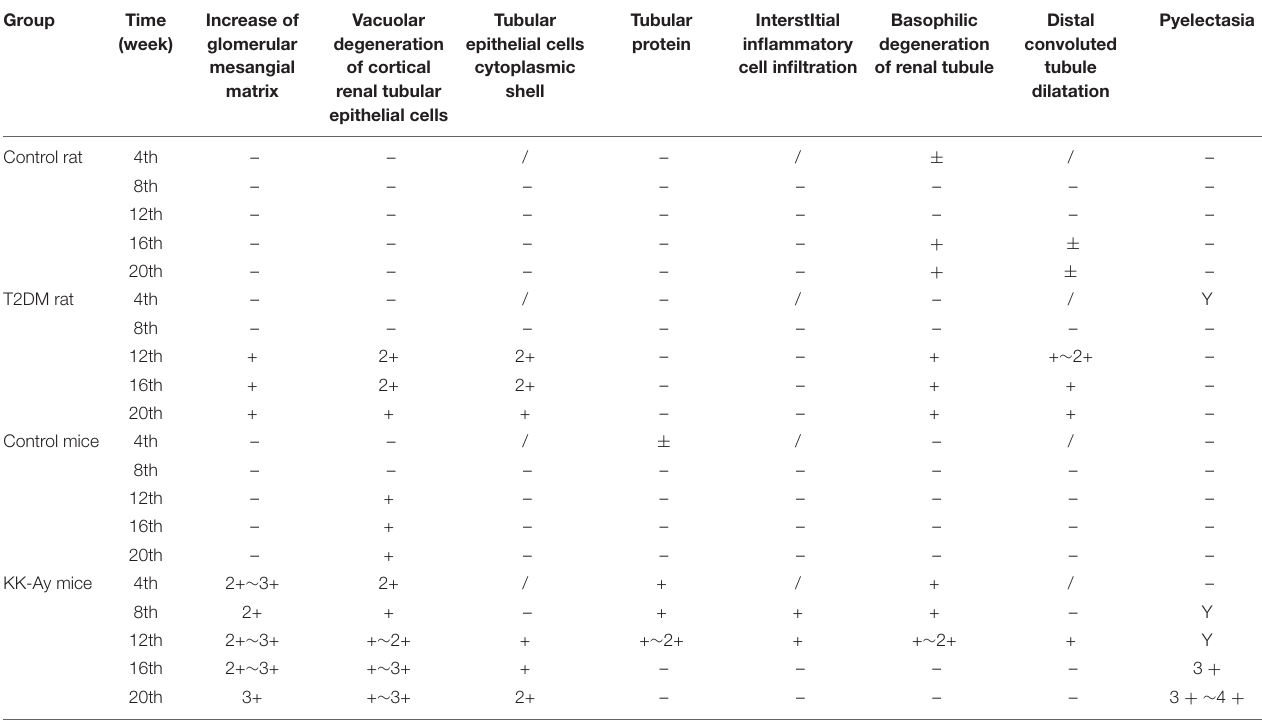
TABLE 2 | Pathological changes of kidney in different diabetes mellitus models. Group